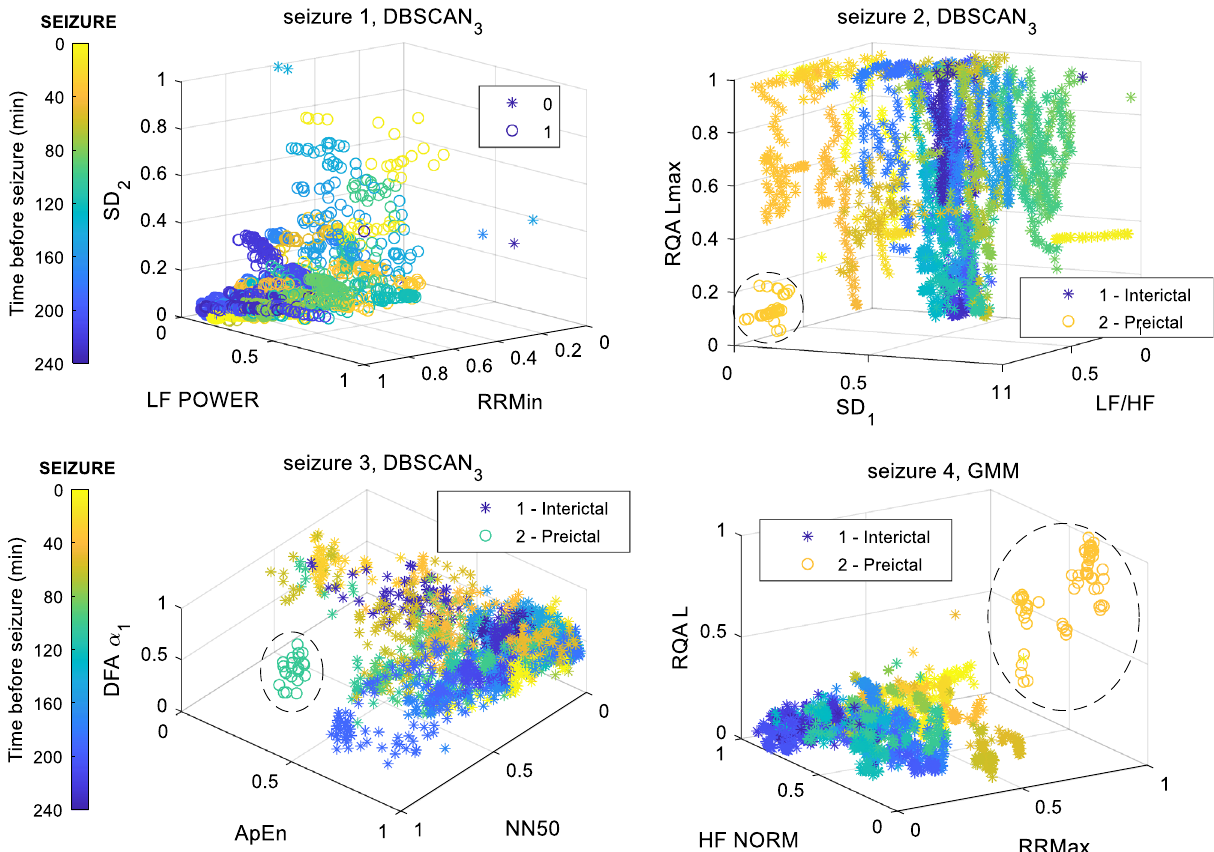
Figure 2. Representation of clustering solutions for patient 5. The smaller clusters (identified with dashed lines) found for the second and fourth seizures are continuous, lasting for 3.50 and 5.42 min (or comprising 43 and 66 samples), respectively. The smaller cluster for the third seizure is discontinuous and lasts for 1.83 min (i.e., 23 samples). The three accepted solutions (for the last three seizures) correspond to Dunn’s index (DI) values of 0.1555, 0.1576 and 0.1585, respectively. No clustering solutions were accepted for the first seizure; a solution containing noisy samples was randomly selected and is represented